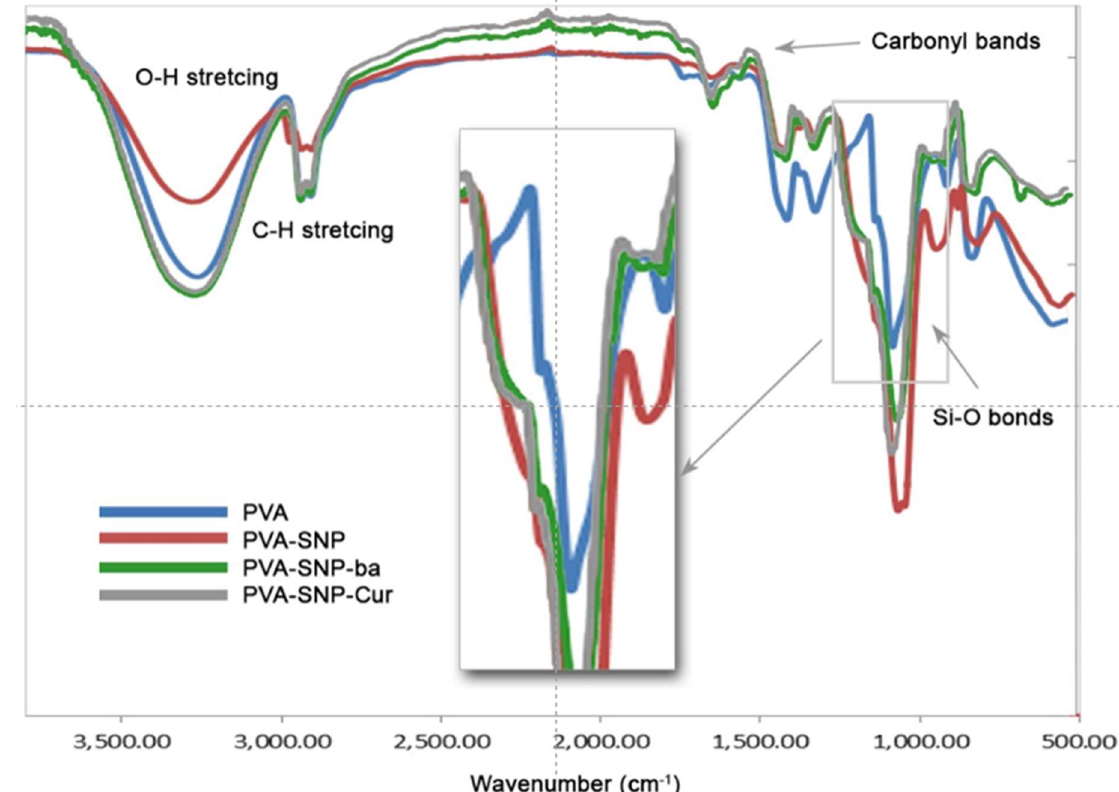
Figure 2. ATR-FTIR spectra of PVA, PVA-SNP, PVA-SNP-cur and PVA-SNP-ba.